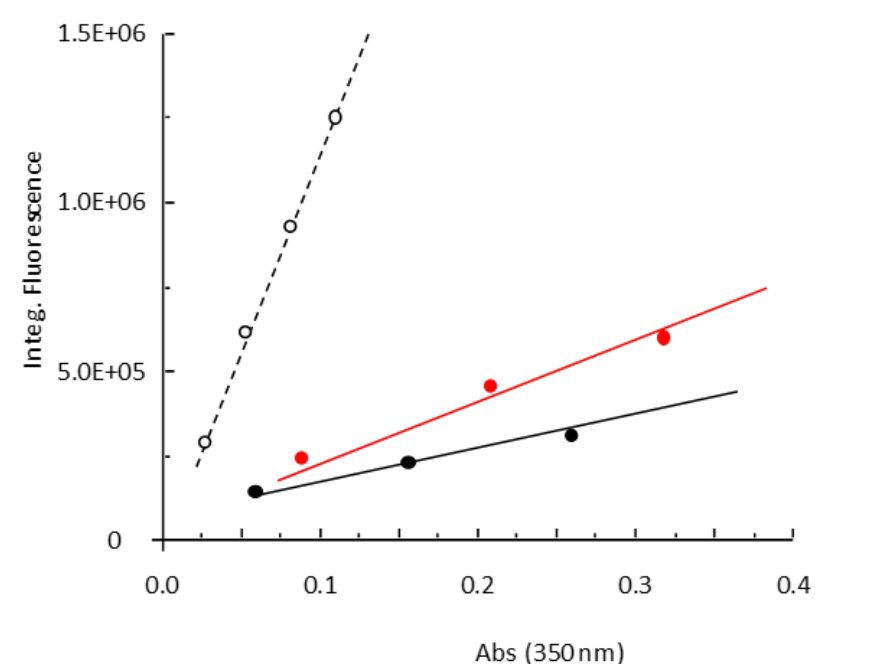
Figure 7. Integrated fluorescence vs. absorbance gradients of DPA (reference: white circles and dotted line), P797 (black circles and black line) and oxidized P797 solutions-1 Faraday/mole electrooxidation of P797 (red circles and red line) in acetonitrile + TBABF 4 0.1 mol.dm − 3 . Concentrations are in the range 10 − 5 –4 × 10 − 5 mol.dm − 3 .